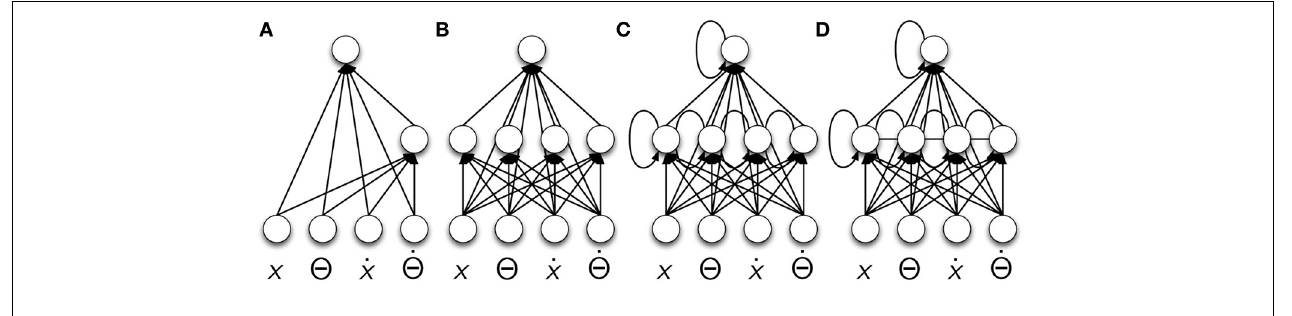
FIGURE 2 | Controller architectures for the cart-pole swing-up task. The input neurons are bare buffer neurons whereas the hidden and output neurons have tanh transfer-function. (A) from